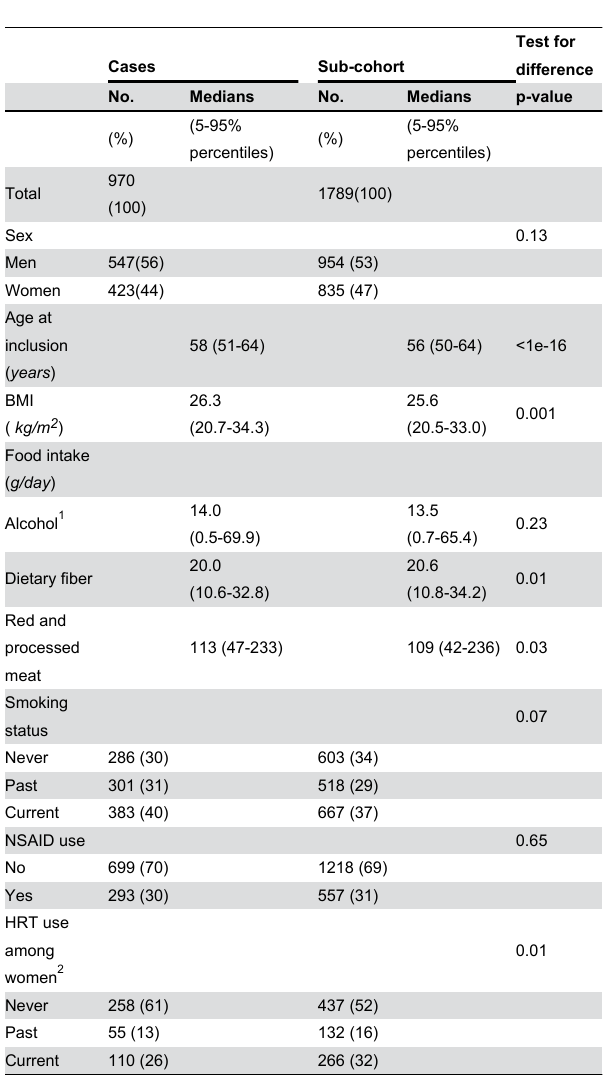
Table 2. Incidence rate ratios and 95% confidence intervals for the studied gene polymorphisms in the Diet, Cancer and Health